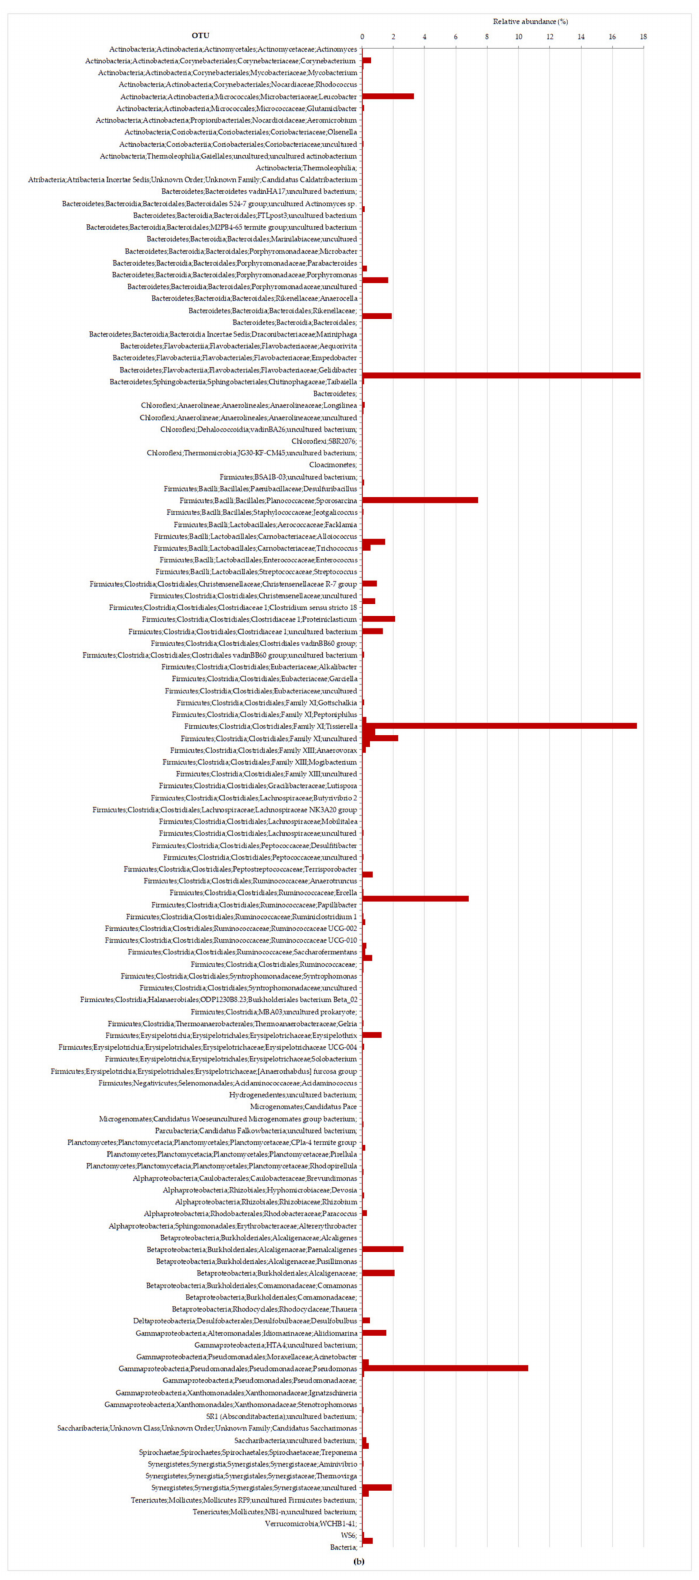
Figure 6. Relative abundance of bacterial communities at genera level in samples from anaerobic digestion phases ( a ) HRT 6.7 d and ( b ) HRT 3 d, in the hybrid anaerobic reactor. The abundance is presented in terms of a percentage of the total number of sequences in a